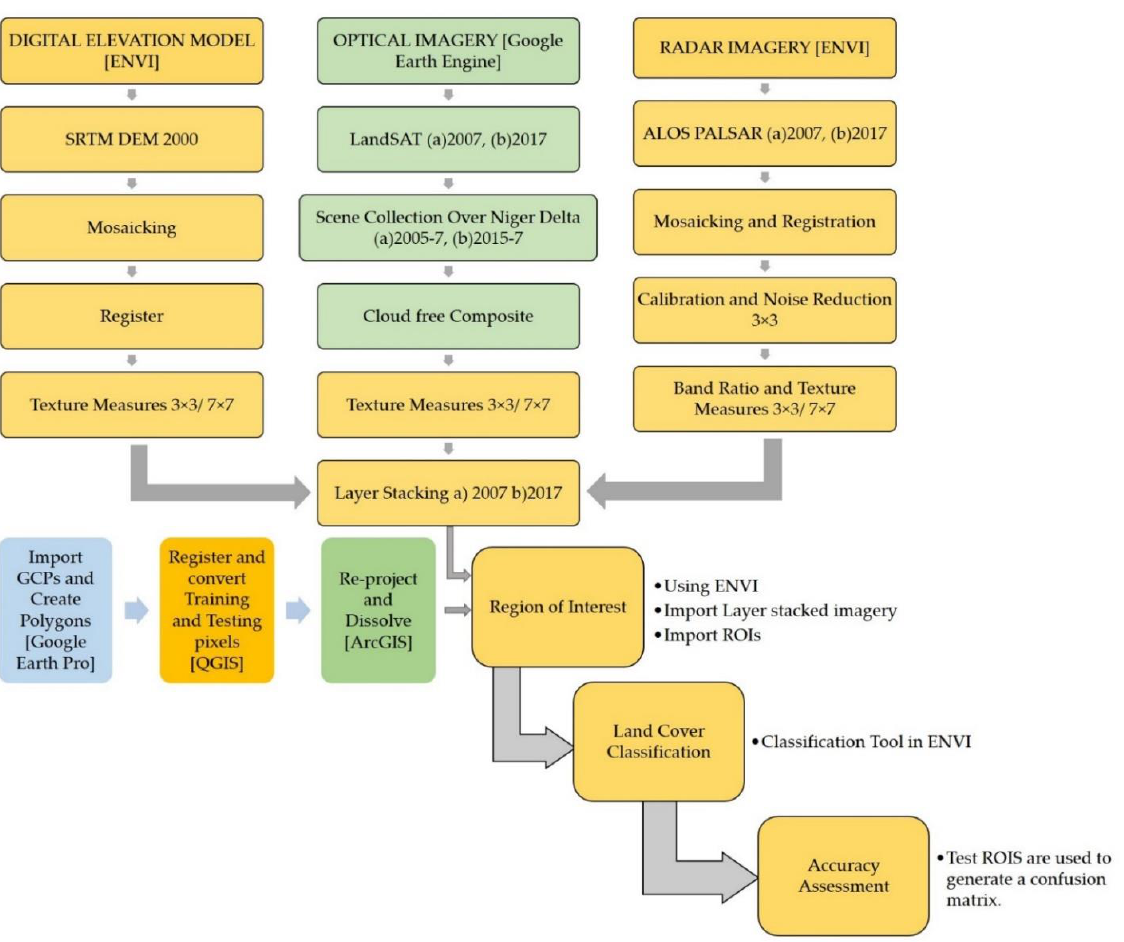
Figure 3. Image processing steps prior to land cover (LC) classification. Digital Elevation Model (DEM), Advanced Land Observing Satellite (ALOS) Phased Array L-band Synthetic Aperture Radar (PALSAR) and Landsat were pre-processed separately before they were stacked together with the Shuttle Radar Topography Mission (SRTM) DEM 30m resolution. We grouped both Landsat and ALOS PALSAR data for the year 2007 and 2017. Each color code represents the different software used for analysis.